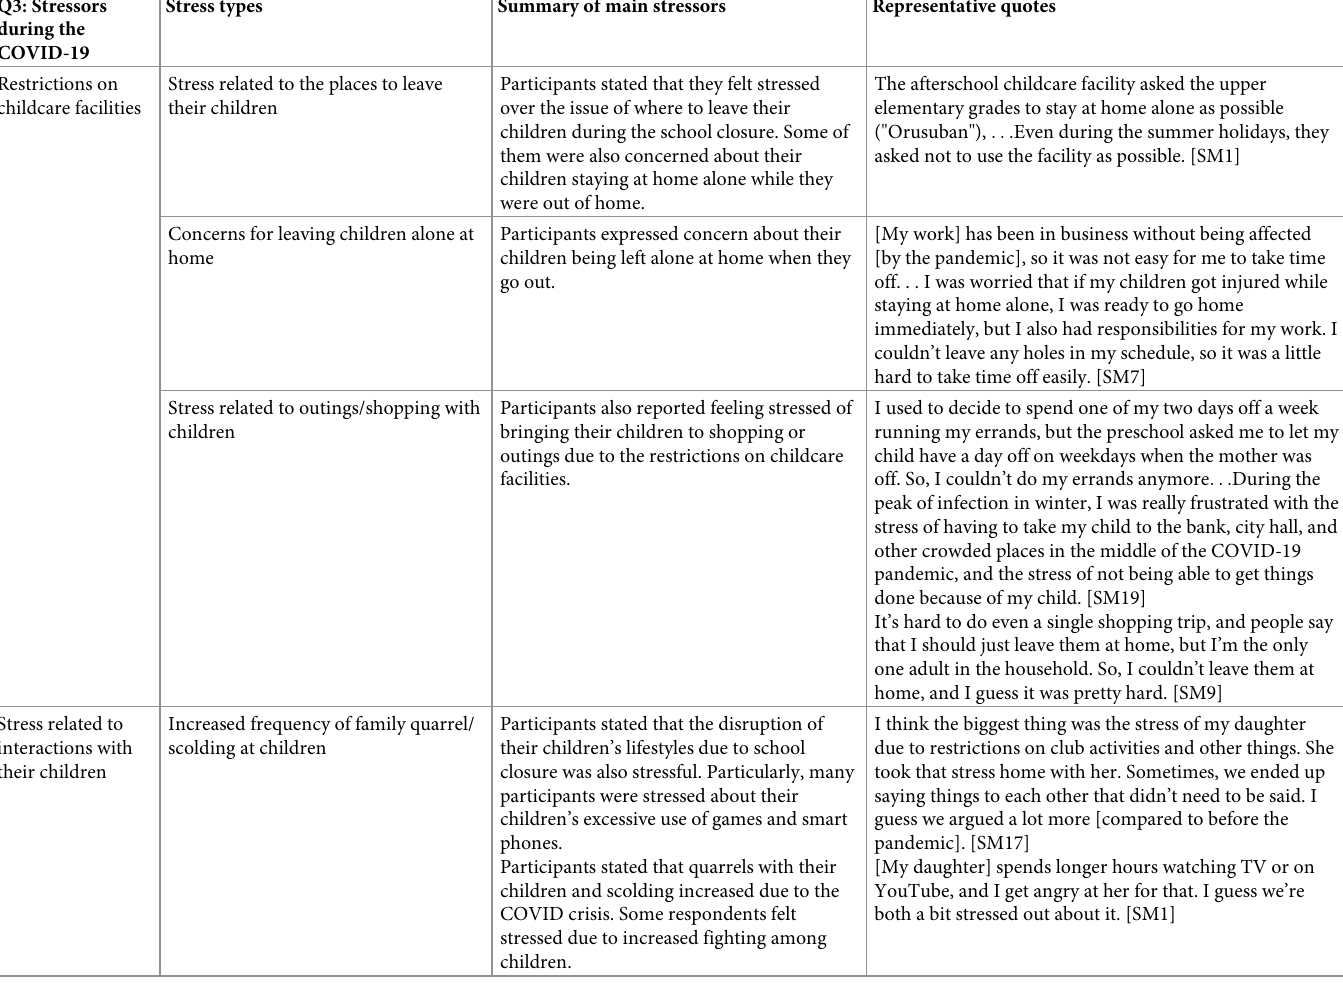
Table 2. Stressors among single mothers during the